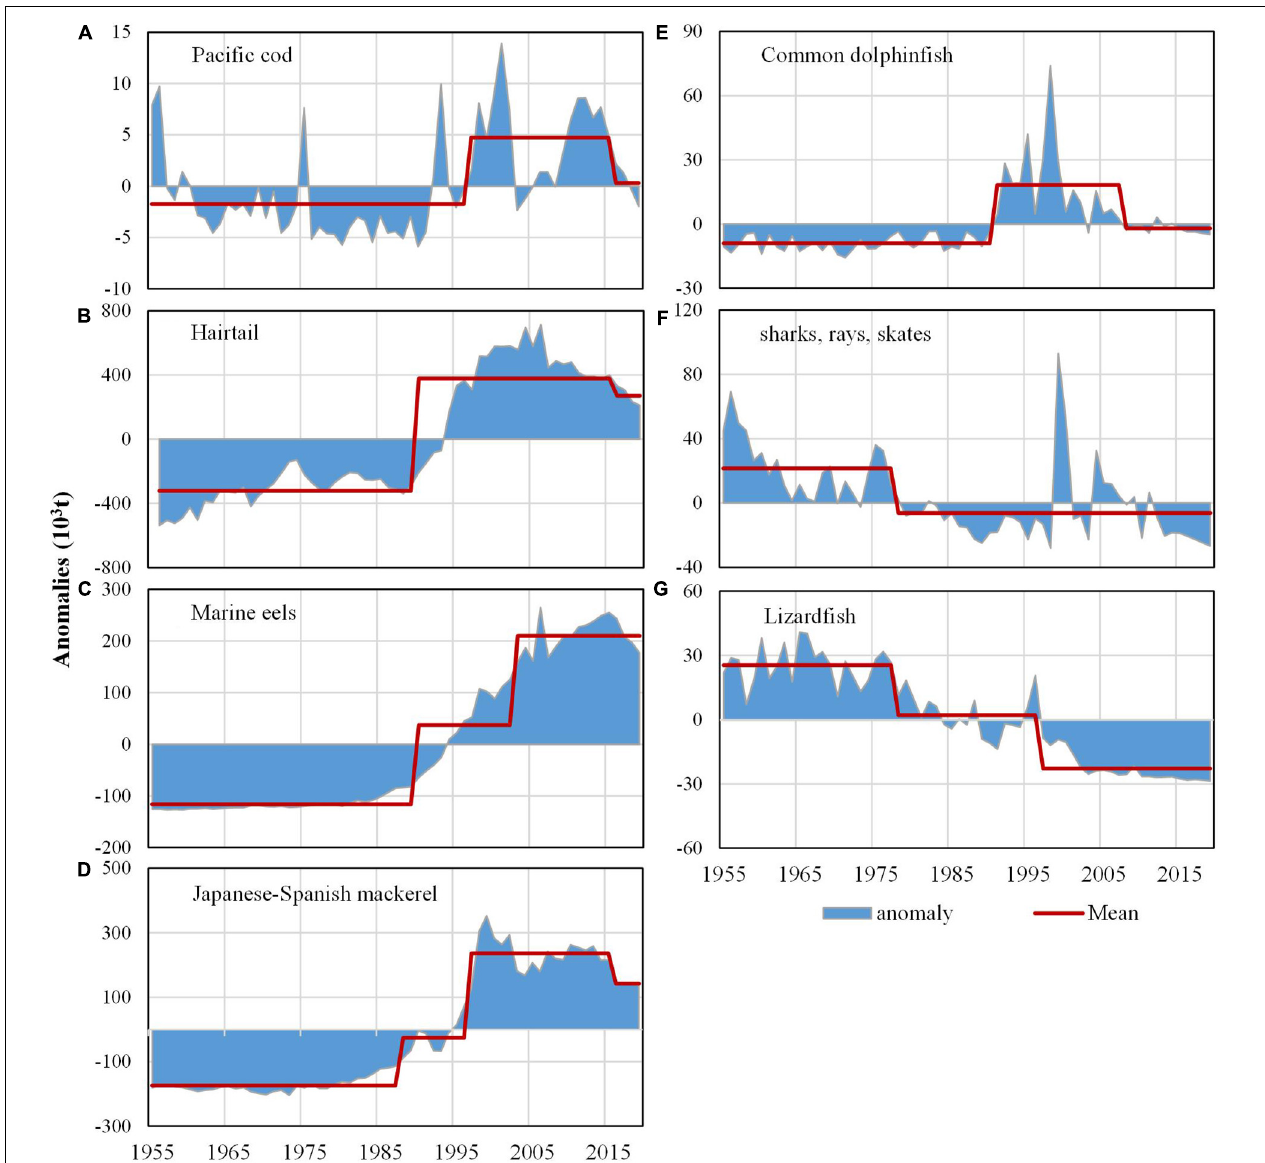
FIGURE 3 | Catch of piscivorous fish in China: (A) Pacific cod, (B) Hairtail, (C) Marine eel, (D) Japanese-Spanish mackerel, (E) Common dolphinfish, (F) Sharks, rays and skates, and (G) Lizardfish. Shaded areas show catch anomalies; red lines represent means of anomalies in different phases that were calculated by STARS.